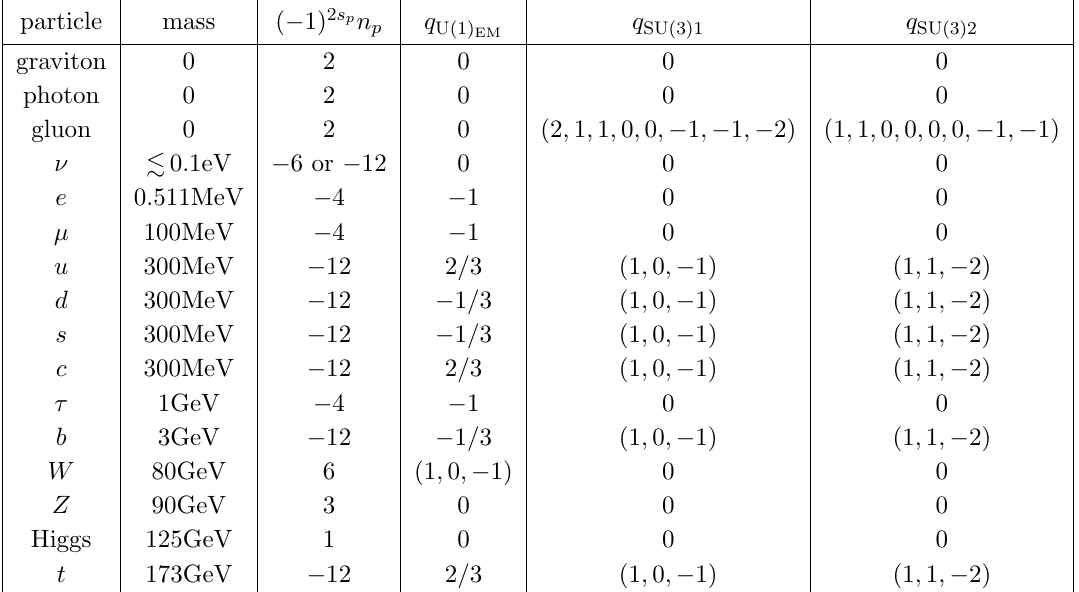
Table 3 . The particle contents contributing to the Casimir energy above the GeV